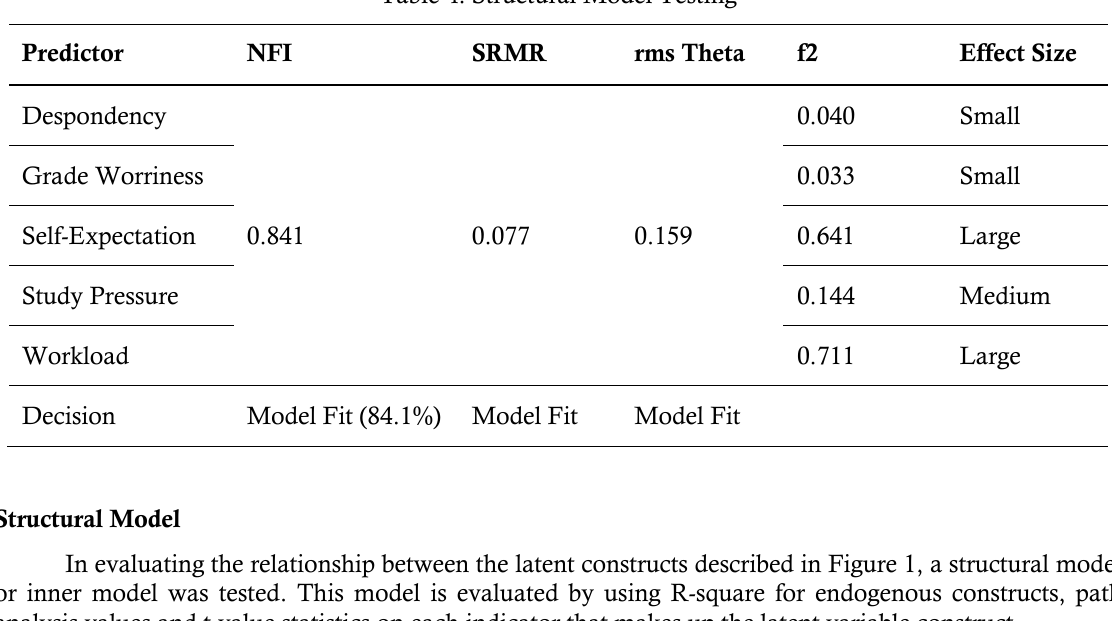
Table 4. Structural Model Testing